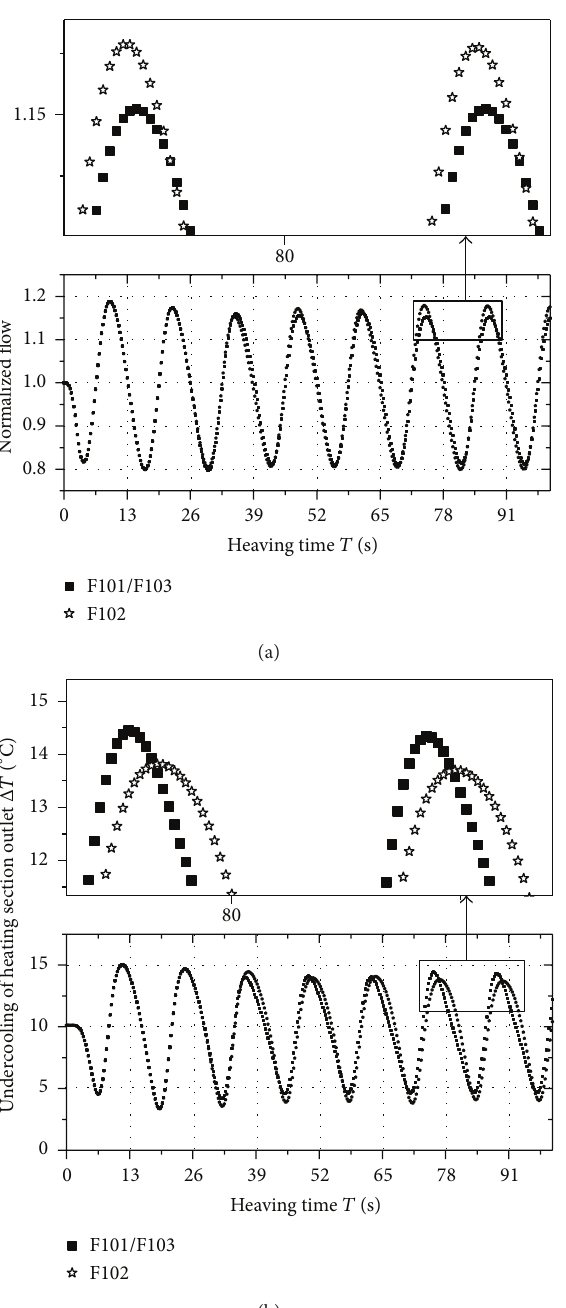
Figure 5: Flow and condensate depression of channel outlet of the left and the intermediate heating section in heaving motion with strength ) = 0.4 g and cycle 𝑇 = 13 s: (a) normalized flow; (b) condensate depression. (𝑔 − 𝑎 𝑜𝑧